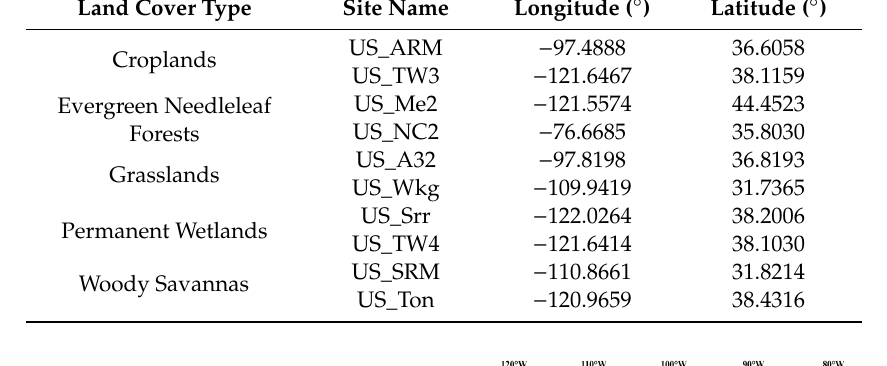
Table 1. The information of the AmeriFlux sites used in this study. Land Cover Type